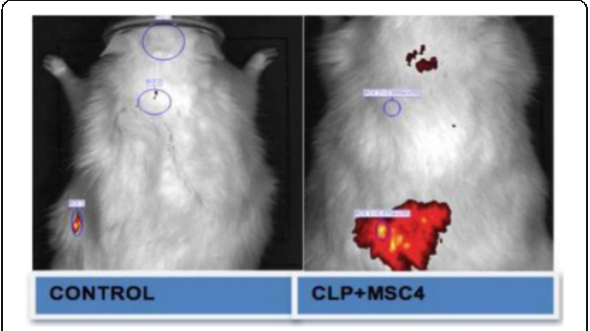
Fig. 57 (abstract A143). In Vivo Imaging (IVIS) of GFP, DF-MSCs